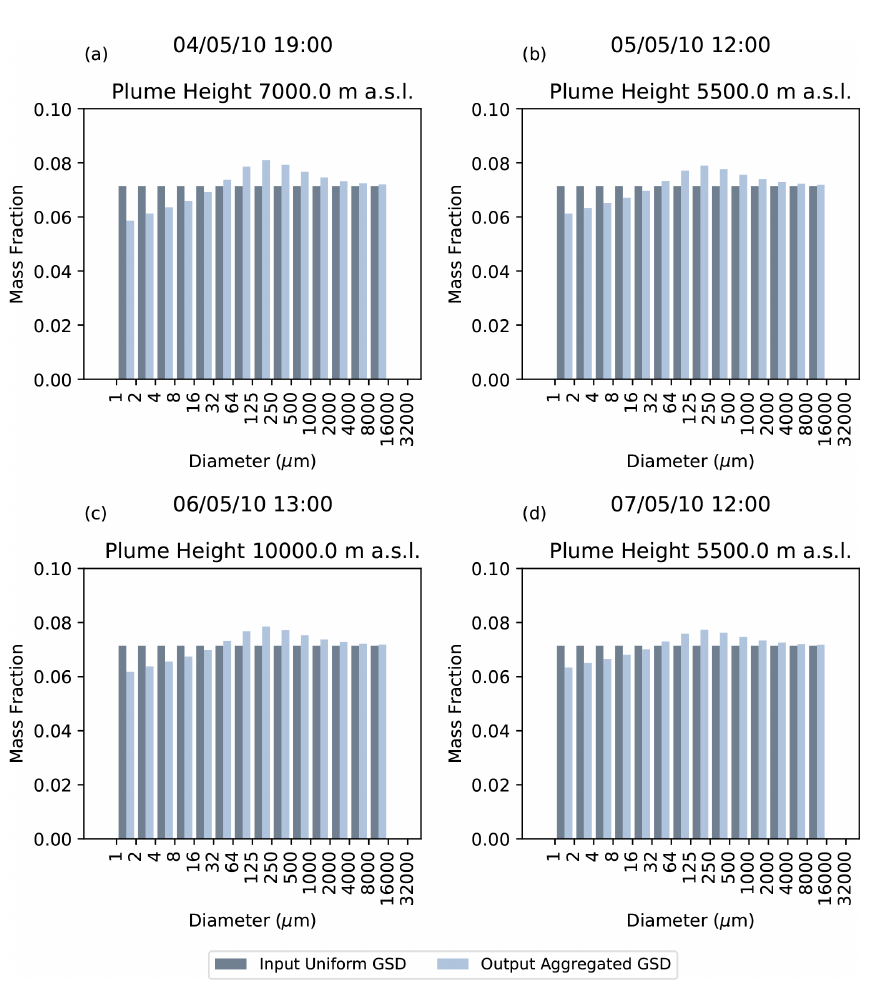
Figure 2. Modelled aggregated GSDs corresponding to the times and phase conditions shown in Fig. 1. The aggregation scheme is initialized with a GSD with a uniform distribution of mass, as indicated by the dark blue